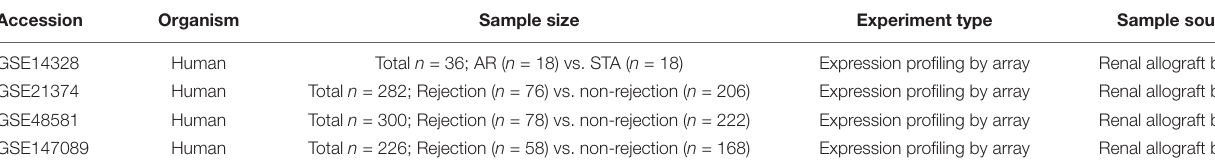
TABLE 4 | Summary of selected GEO data sets.